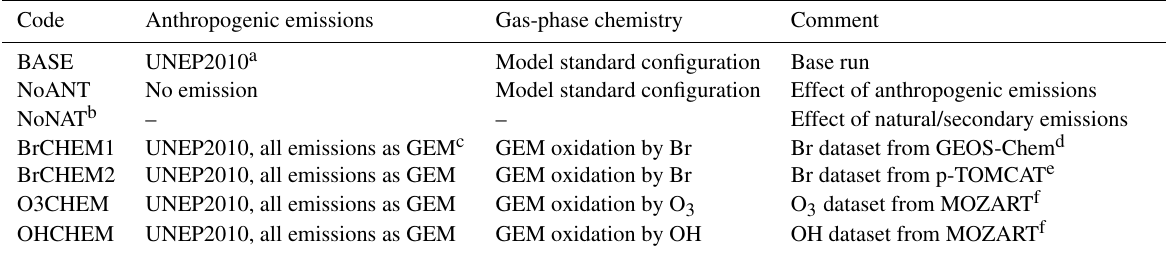
Table 2. Specifications of model